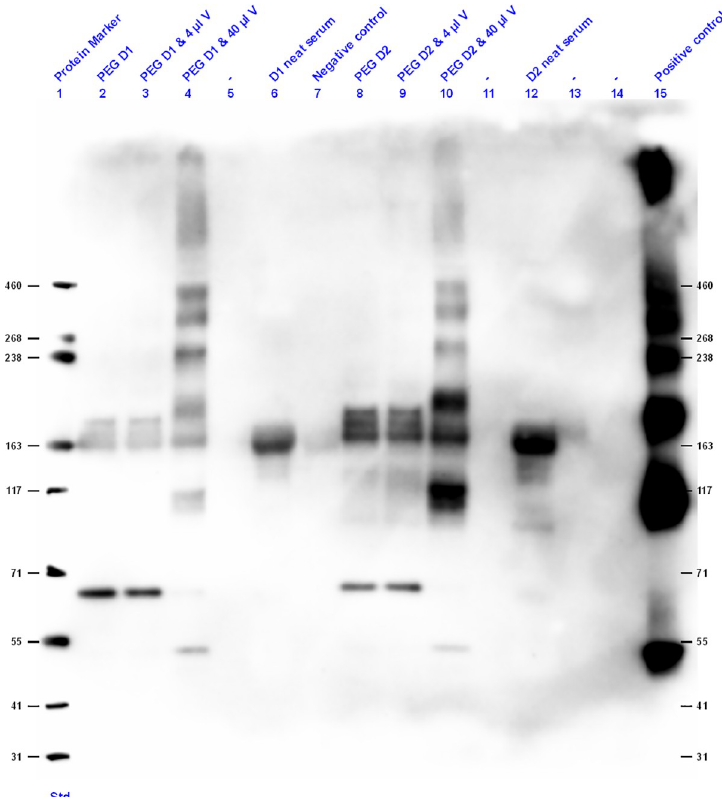
Fig 3. H1N1 Western blotting of PEG precipitates from two healthy adult control samples, healthy adult sera, PBS as a negative control and flu vaccine as a positive control, showed that PEG can precipitate in vitro ICs. Lane one is the Precision Plus protein standard ranging from 31 to 460 kDa. Three μ g of protein per lane was loaded on a 3–8% Tris-acetate denaturing SDS-PAGE gel, blotted to nitrocellulose membrane and incubated with rabbit anti- H1N1 influenza A virus (primary antibody), goat anti-rabbit Immunoglobulin HRP (secondary antibody) and stained using the ECL kit. D stands for Donor, V for Vaccine and Negative control (Lane 7) is PEG with PBS. Lane 15 is a positive control, the influenza